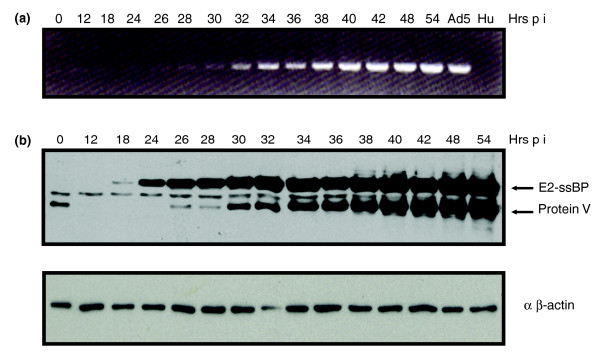
Kinetics of the Ad5 infectious cycle in quiescent HFFs. Quiescent human foreskin fibroblasts (HFFs) were infected with 30 plaque forming units/cell adenovirus type 5 (Ad5) and total DNA or protein extracts prepared after various periods of infection, as described in Materials and methods. (a) Concentrations of viral DNA were determined by limiting polymerase chain reaction amplification of a sequence with the E1A gene. Purified Ad5 (Ad5) and human (Hu) DNAs were amplified as positive and negative controls, respectively. (b) The viral early E2 and late V proteins, and the cellular β-actin protein were examined by immunoblotting.